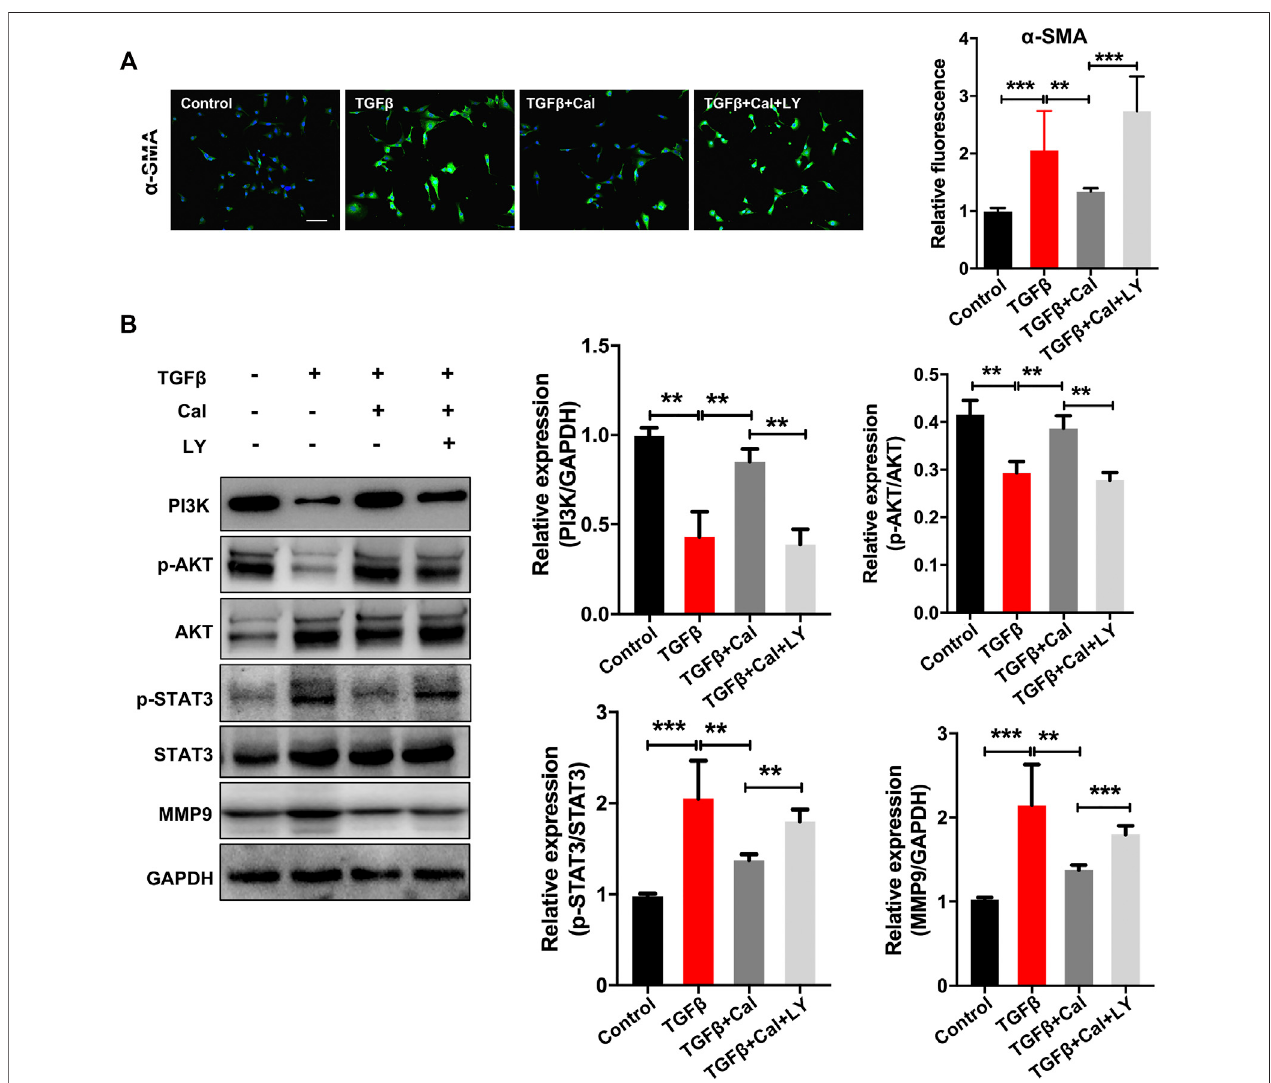
FIGURE6| CalregulatedtheTGF β -activatedPI3K – Aktsignalingpathwayincardiac fi broblasts. (A) Representativeimagesof α -SMAimmunoassayineachgroup. Scale bar = 50 μ m. N = 20 cells per group. (B) Western blot bands of PI3K, AKT, STAT3, and MMP9 and their quantitative results in cells. Data are presented as the mean ± standard error of three independent experiments. * p < 0.05, ** p < 0.01, *** p < 0.001.